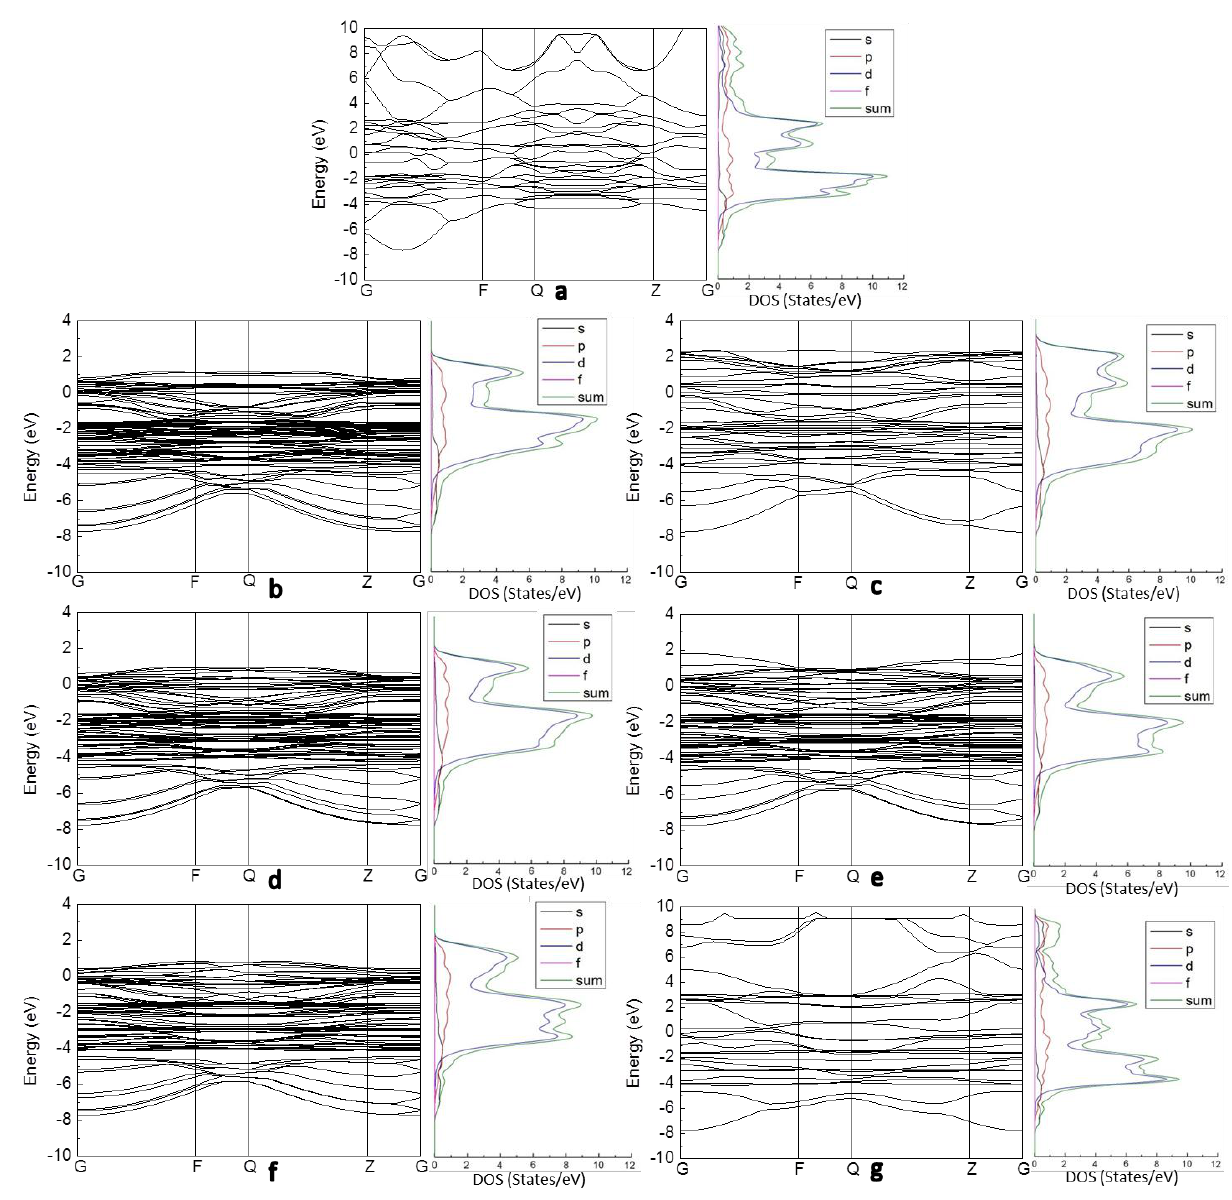
Figure 6. Band structures and associated partial density of states for ( a ) binary Ti 50 Ni 50 ; ( b ) Ti 50 Ni 45 Cu 5 ; ( c ) Ti 50 Ni 37.5 Cu 12.5 ; ( d ) Ti 50 Ni 35 Cu 15 ; ( e ) Ti 50 Ni 31.25 Cu 18.75 ; ( f ) Ti 50 Ni 30 Cu 20; and ( g ) Ti 50 Ni 25 Cu 25 with the Fermi level defined at 0